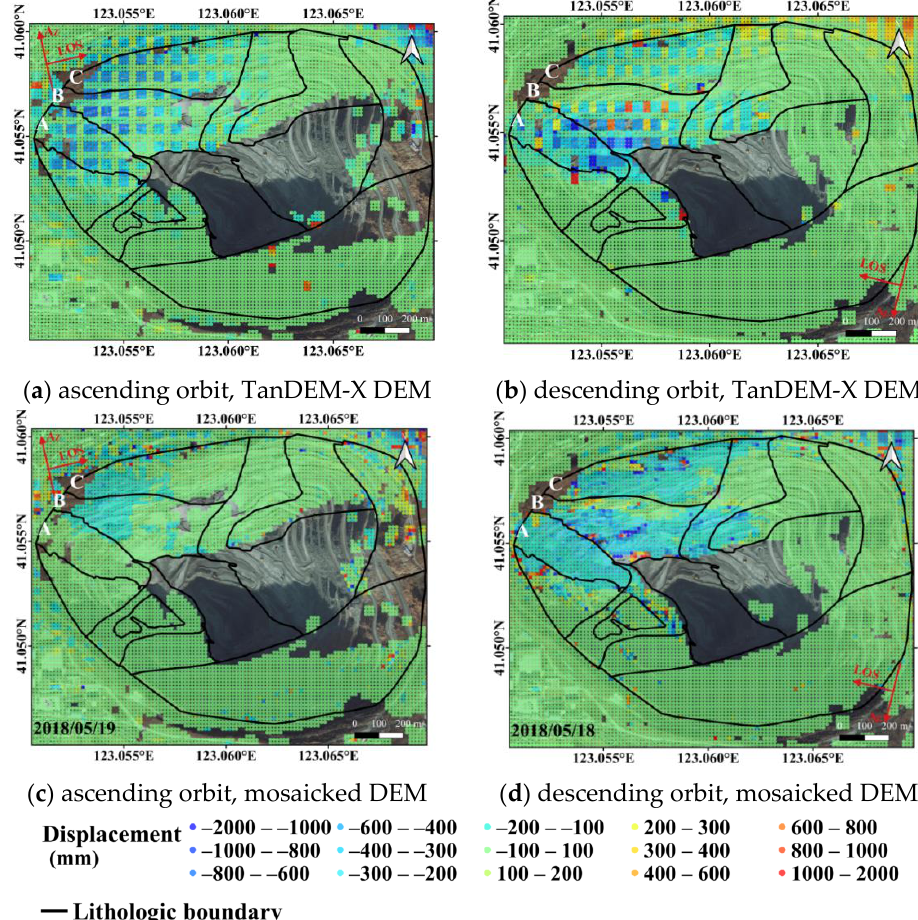
Figure 9. Slope displacement converted from TanDEM-X DEM and the mosaicked DEM: ( a ) ascending orbit, TanDEM-X DEM; ( b ) descending orbit, TanDEM-X DEM; ( c ) ascending orbit, mosaicked DEM; ( d ) descending orbit, mosaicked DEM.